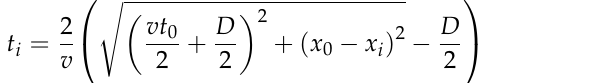
Figure 5. Schematic illustration of the principle of estimating rhizome diameter using the hyper- bolic